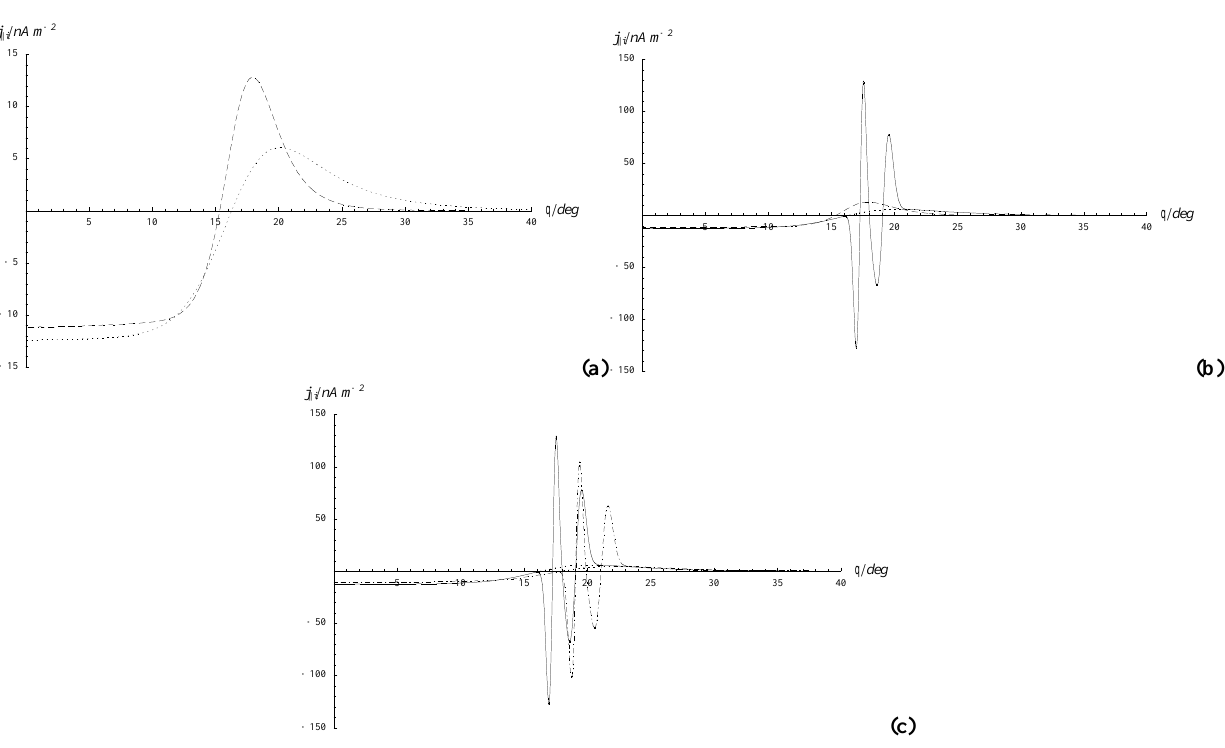
Fig. 6. (a) Plot of the ionospheric field-aligned current density in the Northern Hemisphere versus co-latitude θ , obtained from Eq. (19) with = 1mho. Only the currents associated with the large-scale variations in the angular velocity modelled by Eq. (25) are shown, such that 6 ∗ P the ‘dips’ in the Voyager-1 profile are ignored. The line format is the same as for Figs. 4 and 5, such that the profile for Voyager-1 (without ‘dips’) is shown dotted, while the Voyager-2 profile is shown dashed. (b) Shows the same Northern Hemisphere field-aligned current curves as in (a), but now also including the ‘dips’ in the Voyager-1 profile (solid line). The current scale has also been expanded in order to show the peaks associated with the small-scale Voyager-1 features. (c) Shows a comparison of the Voyager-1 field-aligned current profiles in the Northern and Southern Hemispheres, in the same format as Figs. 4 and